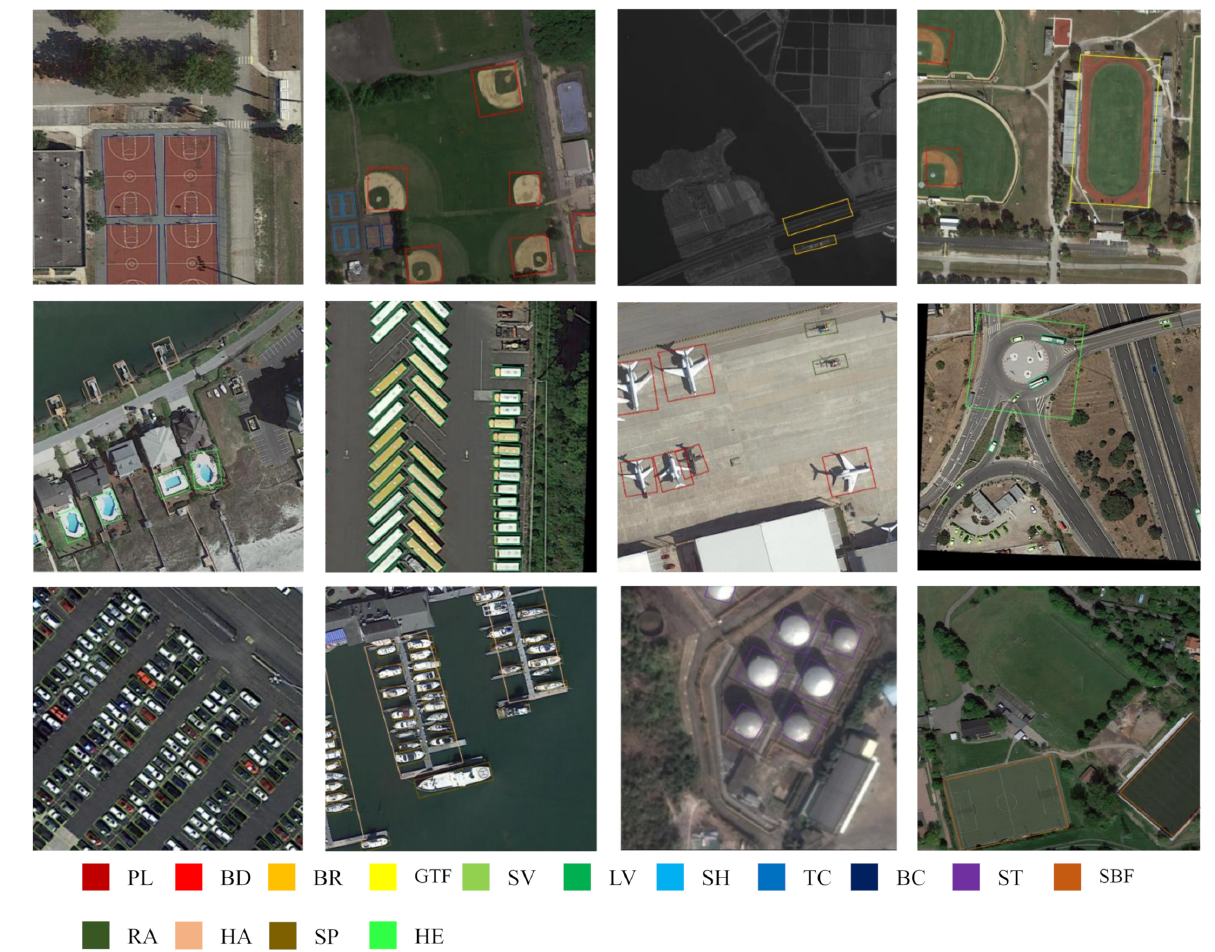
Figure 16. Visualization of the detection results on the DOTA